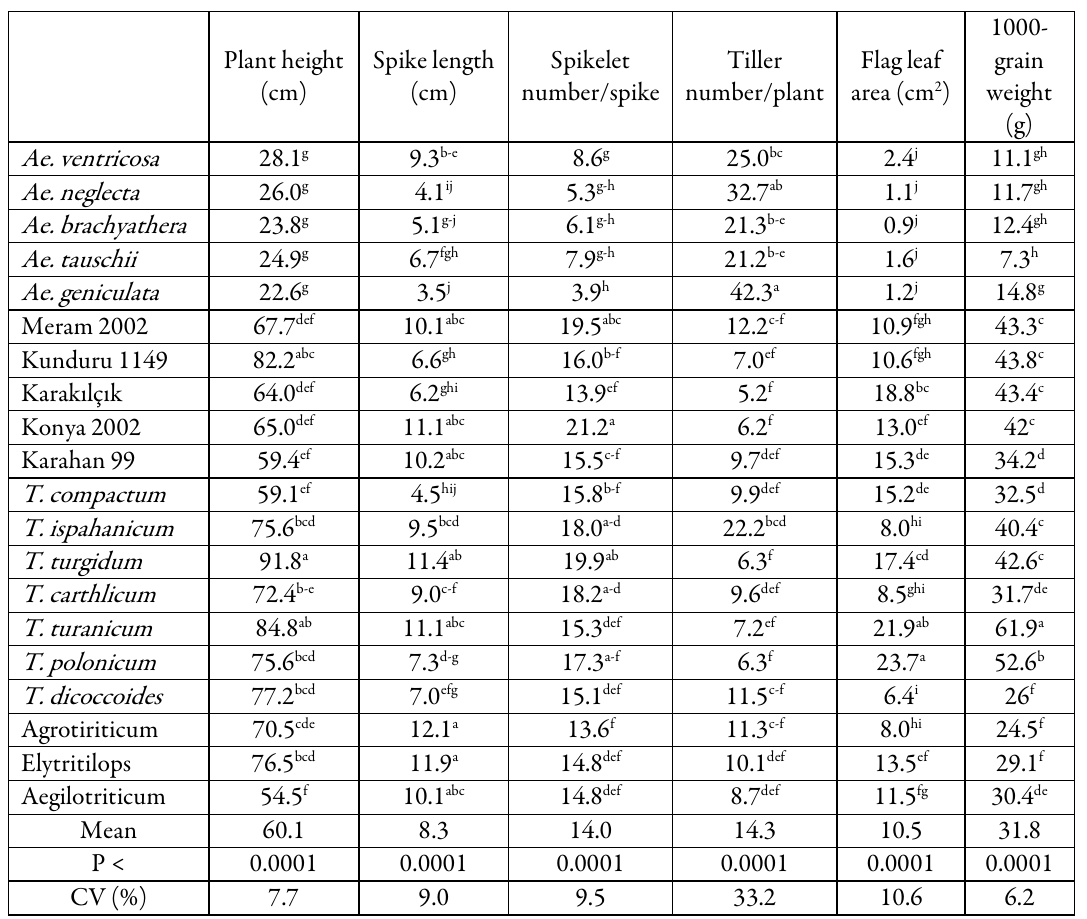
Table 2. Morphological traits of wheat species, Aegilops species, and wheat hybrids under rainfed